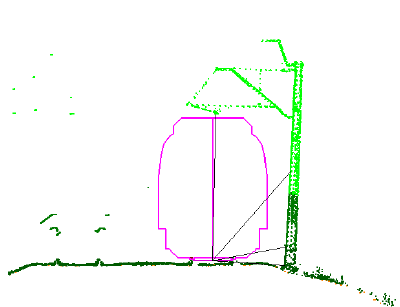
Figure 7. Clearance with measured railway infrastructure elements obtained from rail gauge measurements, at the background of the cloud of points from the Z+F Profiler 9000 system